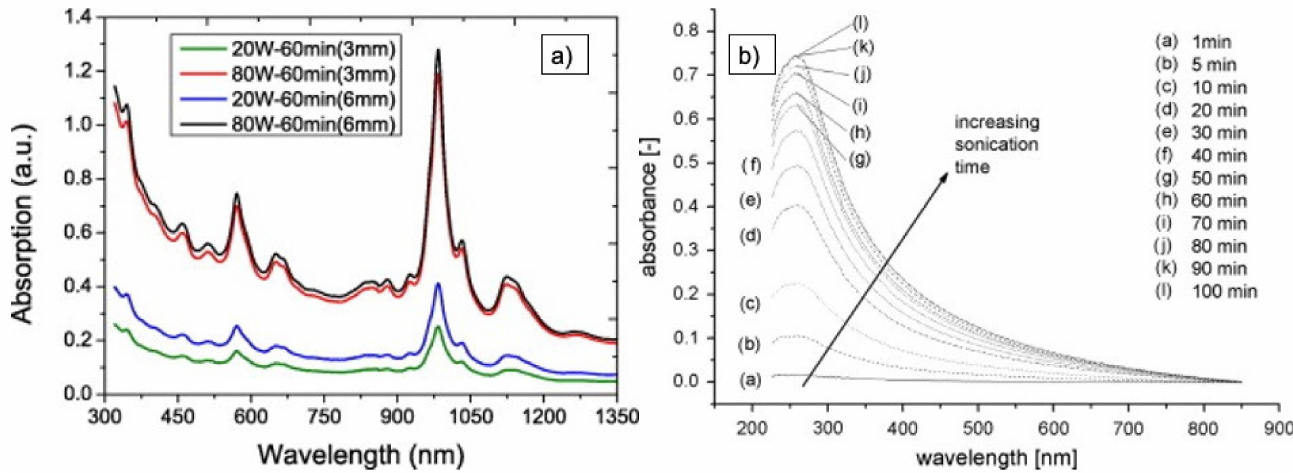
Figure 13. Examples of the application of UV–vis absorption spectroscopy. ( a ) Spectra from SWCNT for two different amplitudes and two different sonication tips, respectively [69]. ( b ) Spectra for functionalized MWCNT dispersed in deionized water + surfactant for increasing sonication time